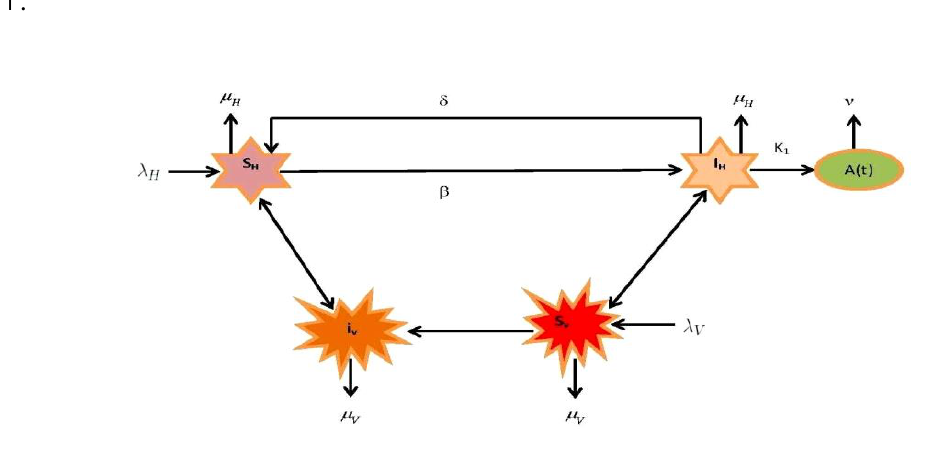
Fig. 1. Compartmental diagram of the model system